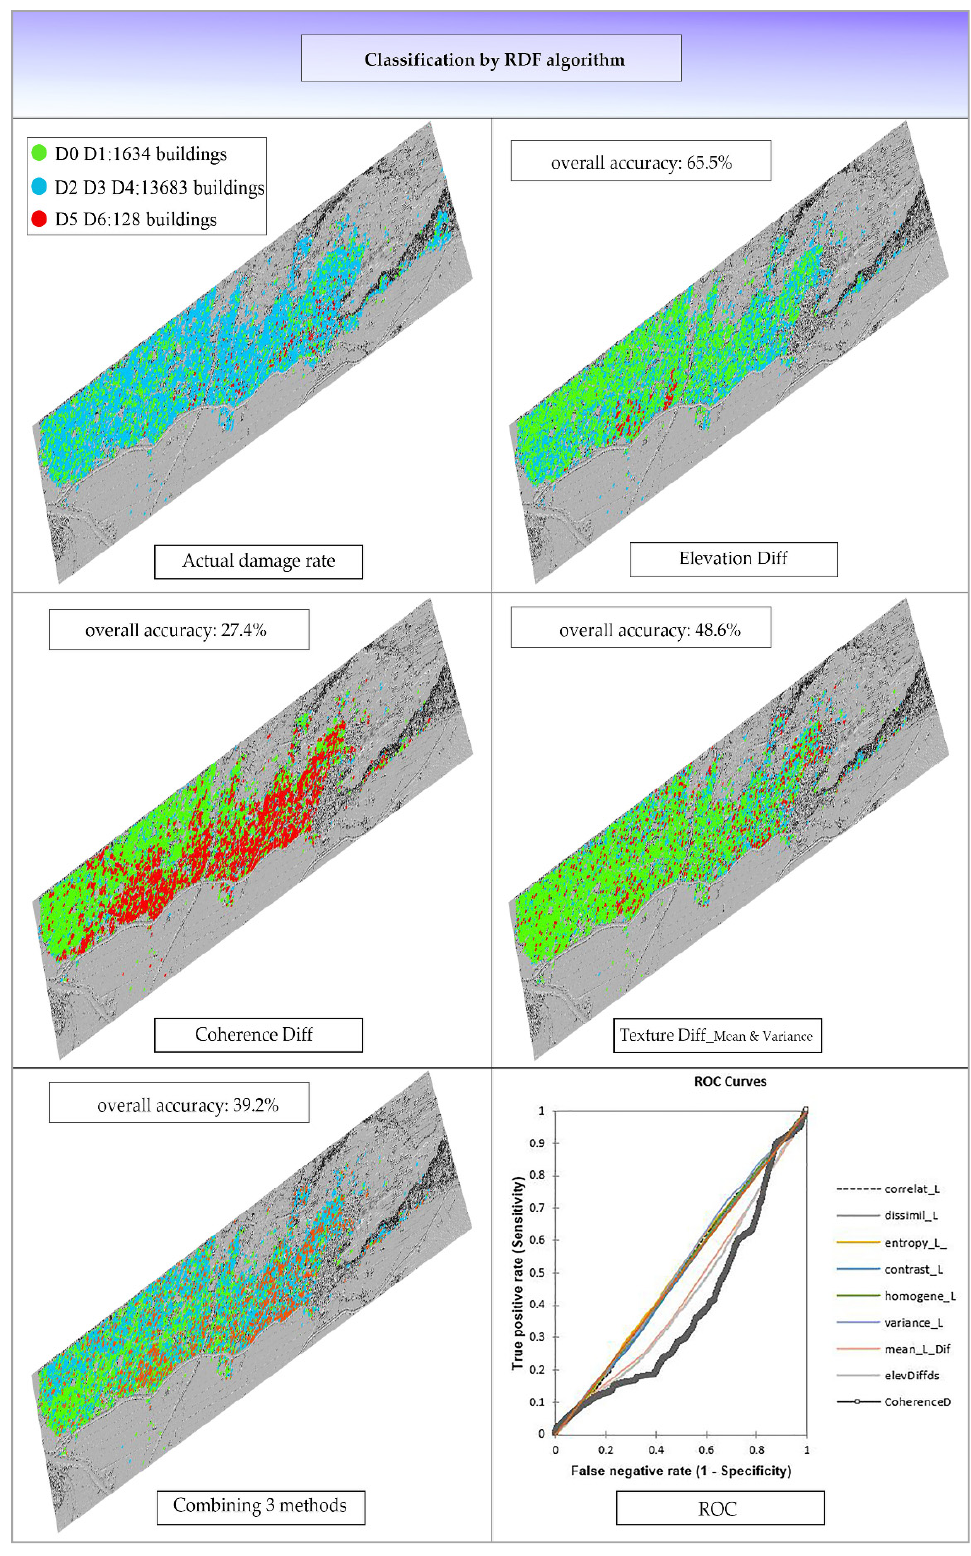
Figure 11. The estimation results of the building conditions by RDF algorithm by considering 4 methods. The green spots represent the intact buildings, blue spots show low to moderate damage and the red spots represent the collapsed buildings. In addition, the Receiver’s Operating Characteristic (ROC) [36] curve (3DR) is shown.